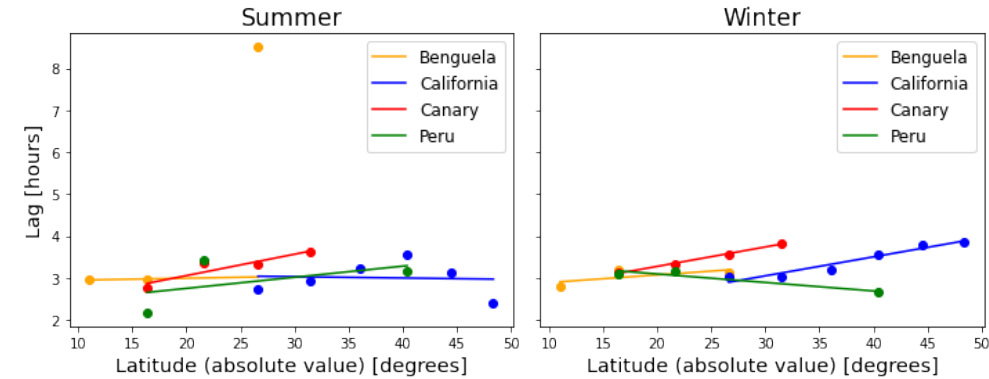
Figure 12. Lag between the divergence and vorticity fields for the four EBC in summer ( left ) and winter ( right ) as a function of the latitude (absolute value). Data points were taken from Table 1, and solid lines correspond to a first-order linear regression for each current, calculated by first excluding data points with a coherence below the 90% confidence interval (as per Table